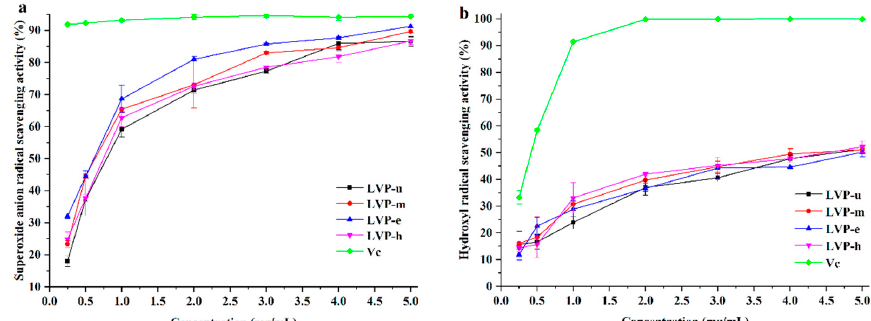
Figure 6. Radical scavenging activities of LVPs extracted by different methods. ( a ) Superoxide anion radical scavenging activity; ( b ) hydroxyl radical scavenging activity.